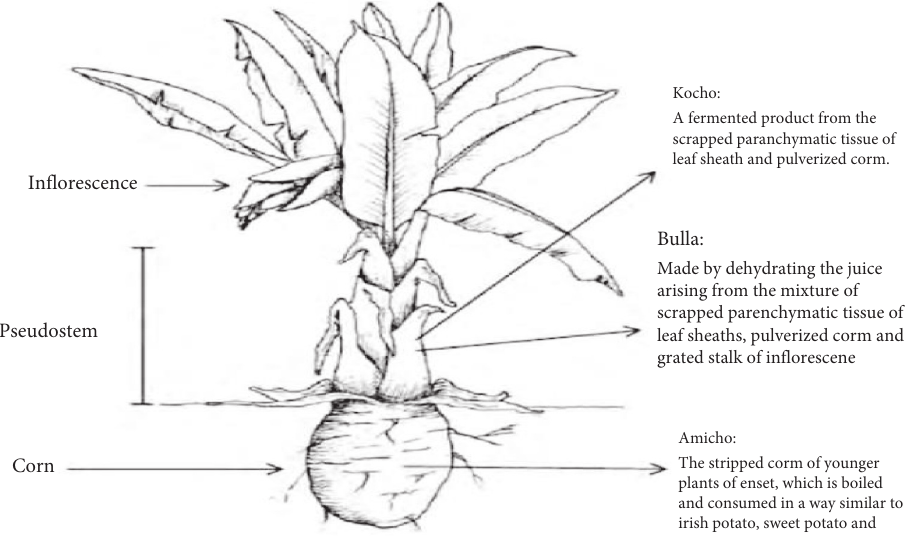
Figure 2: Morphology of the Enset plant and its major food products (Source: [26]).